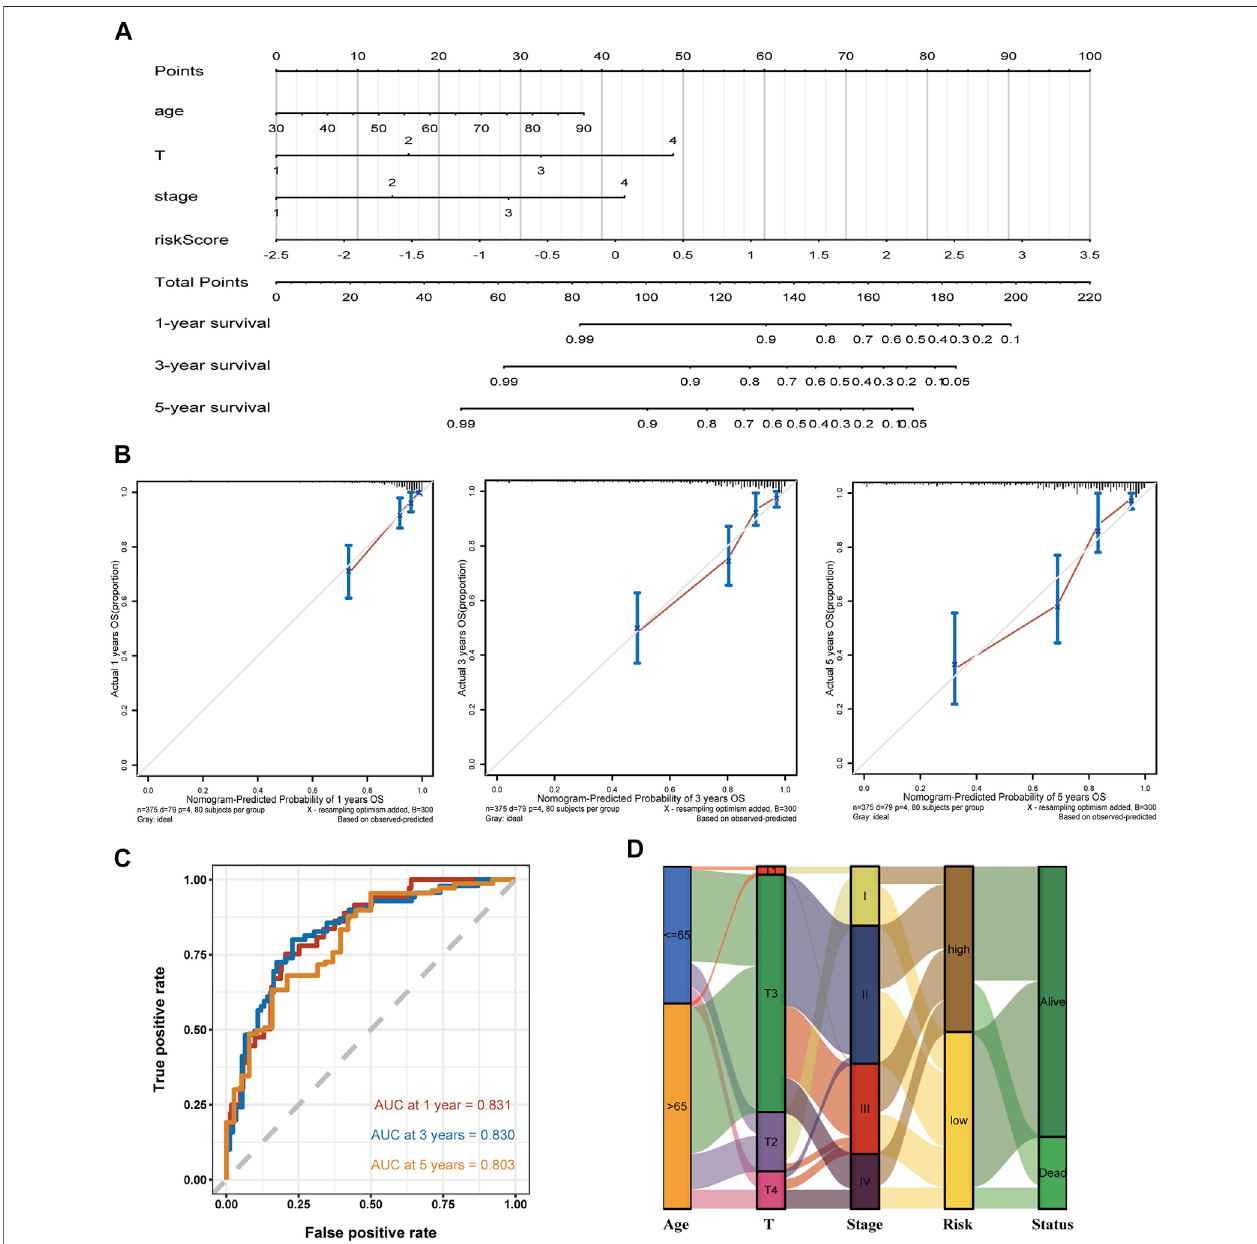
FIGURE5| Establishment ofanomogramusing the screened variable and the validation analysis. (A,B) Theconstructed nomogram and its correctioncurves. (C) AUC of the time ROC at 1, 3, and 5 years are 0.831, 0.830, and 0.803, respectively. (D) Alluvial plot shows the outcome of each COAD patient.